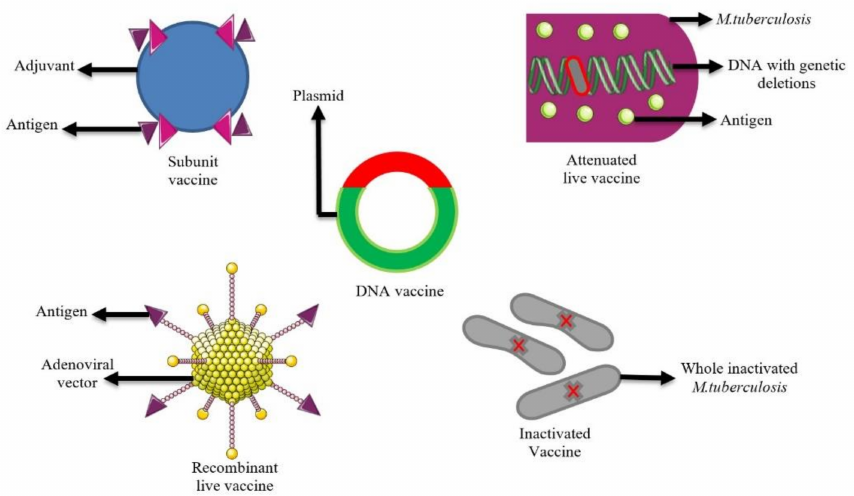
Figure 3. Vaccine